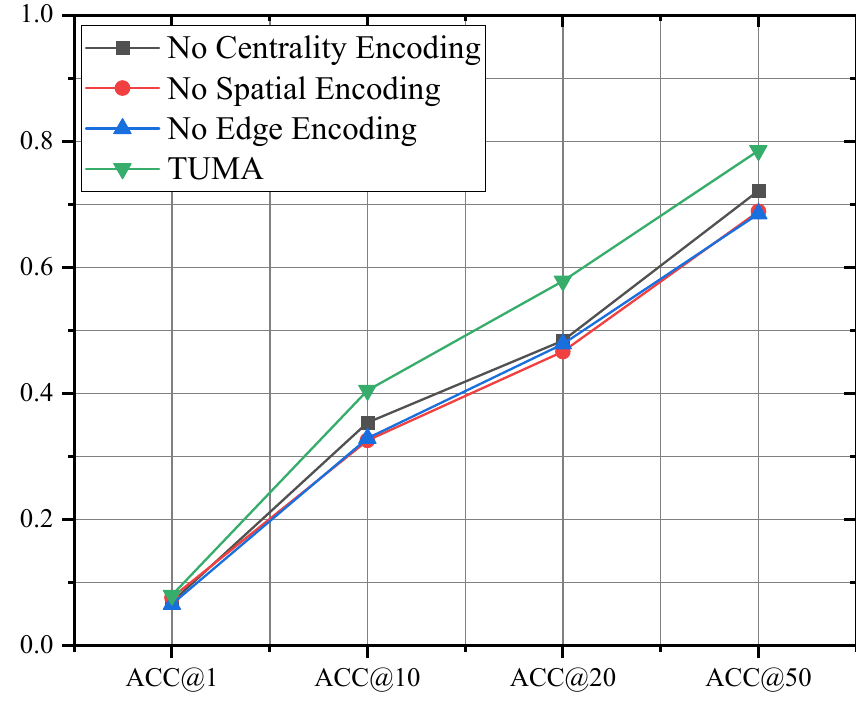
Figure 4. The accuracy of ablation experiments on the Facebook–Twitter dataset.